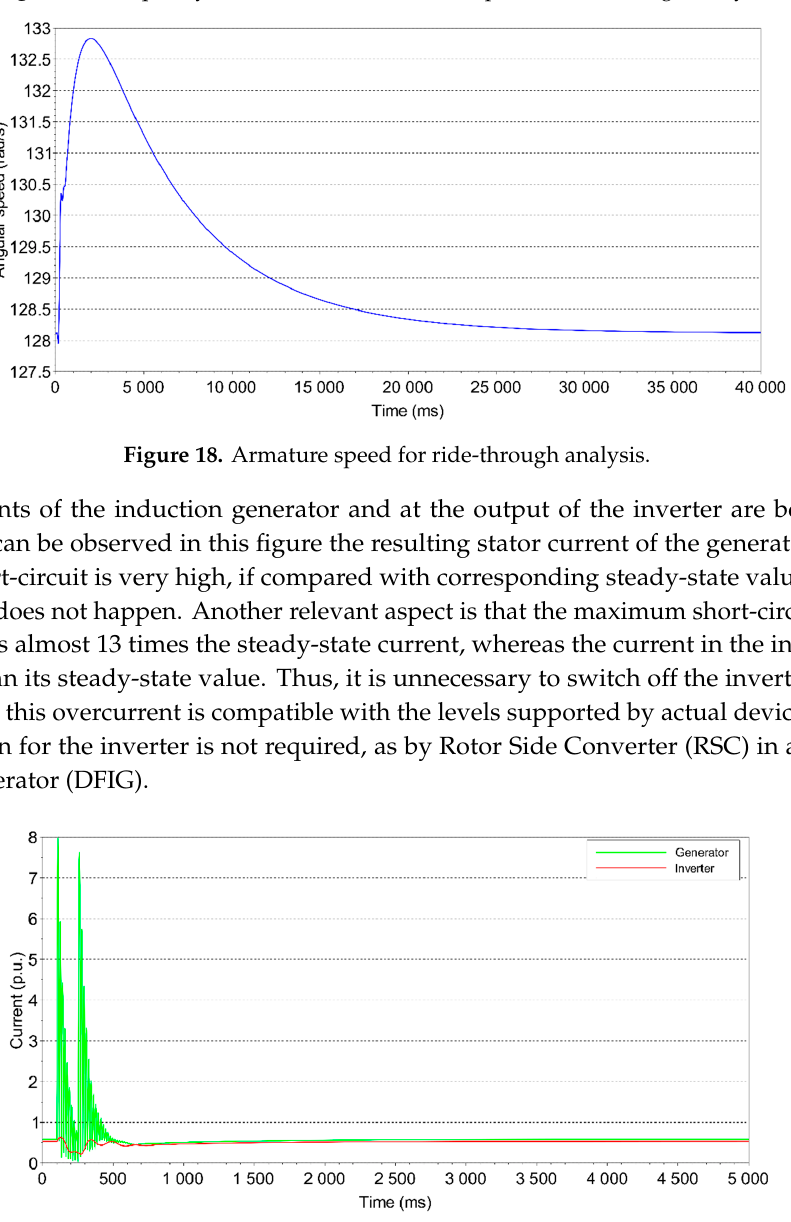
Figure 17. Frequency behavior at the inverter output for ride-through analysis. Energies 2018 , 11 , x FOR PEER REVIEW